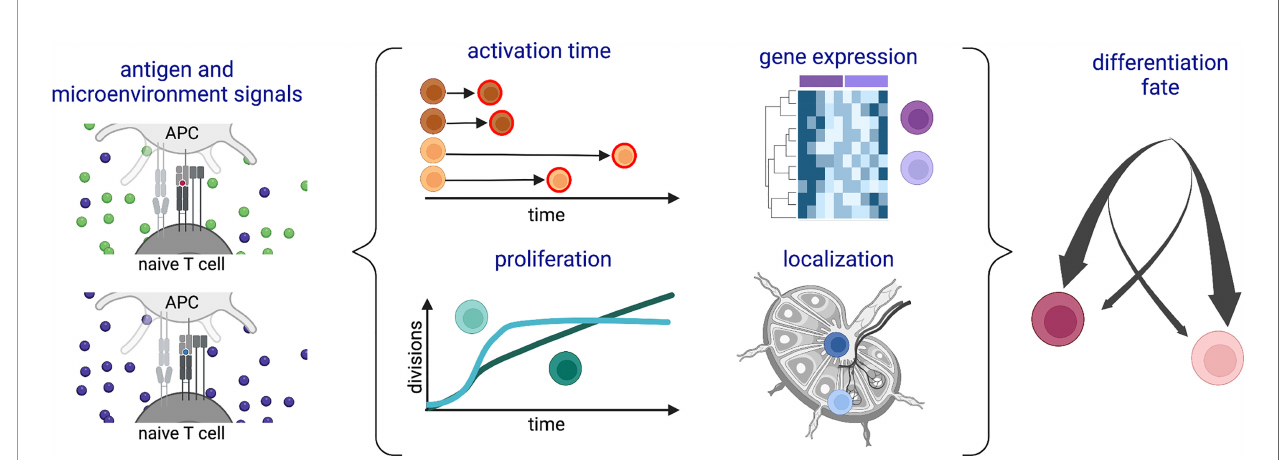
FIGURE 1 | Schematic of types of heterogeneity among a population of CD8 + T cells responding to antigenic stimulation. Variation in (left) antigenic and/or microenvironmental signals is associated with (middle) different time delays before activation, gene expression patterns, proliferation pro fi les, and lymphoid tissue locations during the activation and expansion phases of the response. Many of these forms of heterogeneity are also associated with (right) subsequent differentiation fates. Created with